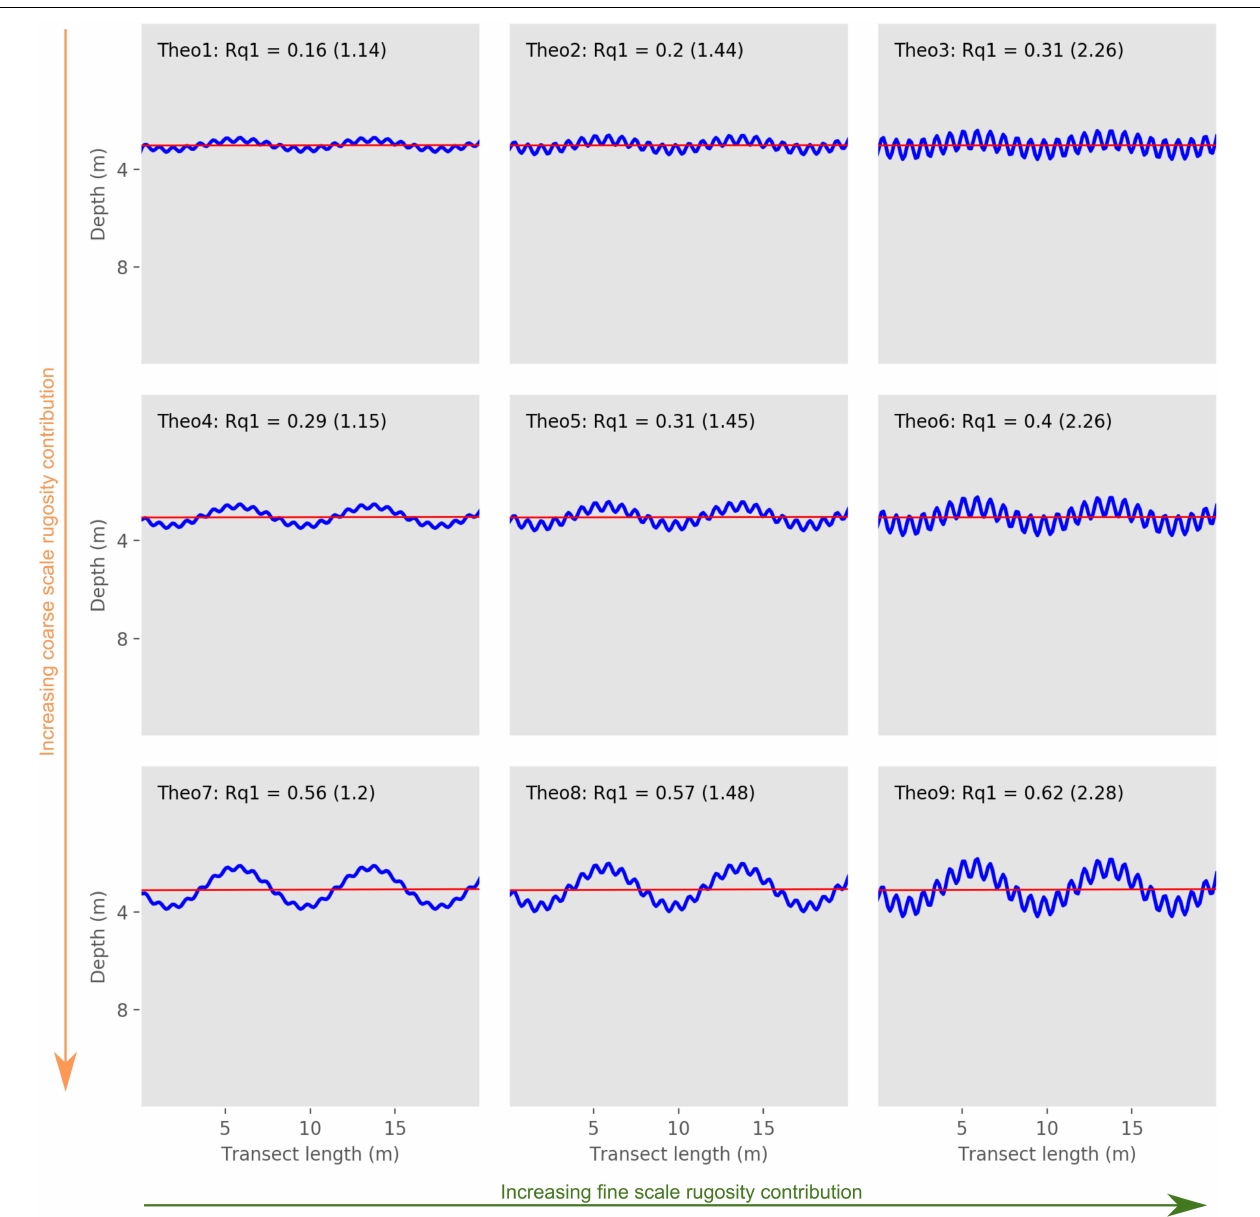
FIGURE 1 | Theoretical depth profiles. Rows and columns represent cases with the same level of coarse and fine scale rugosity, respectively. The orange and green arrows represent the increasing gradient of coarse and fine scale rugosity, respectively. The blue lines represent the actual depth profiles of the nine theoretical transects and the red lines represent the first order of polynomial. Rq1 value is reported for each transect, along with its chain index score in parentheses.